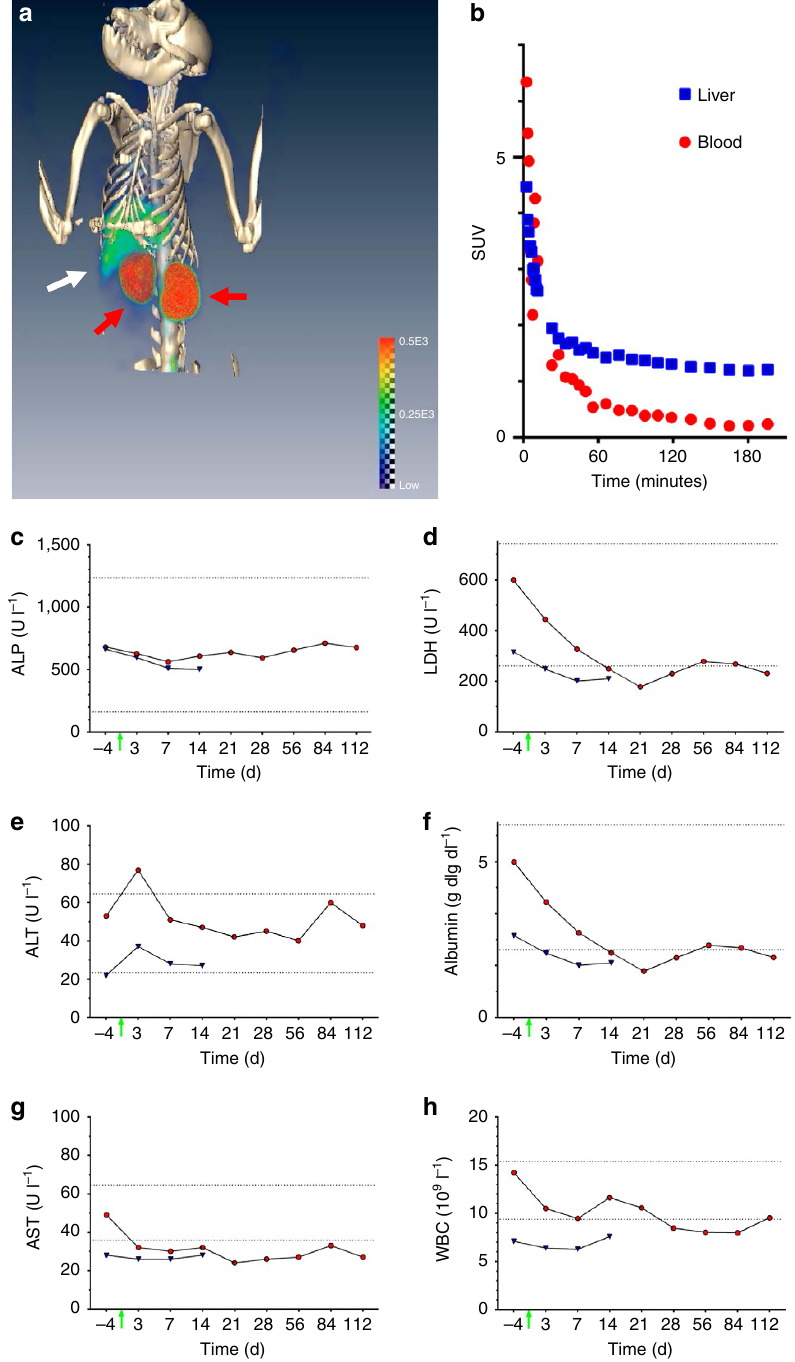
Figure 5 | Pharmacokinetics and toxicology of fCNT in non-human primates. A pair of 5kg cynomolgus monkeys received an intravenously administered dose of [ 86 Y]fCNT (1mgkg (cid:2) 1 ). ( a ) A fused PET/CT image of [ 86 Y]fCNT showing liver (white arrow) and kidney (red arrows) distribution. ( b ) Time– activity curves for blood (red circles) washout and hepatic (blue squares) uptake. Biomarkers for hepatic functions in the pair of animals (red circles and blue triangles) were unchanged relative to baseline values at day minus 4 (NB, the green arrow indicates the time of injection and imaging). The values for ( c ) alkaline phosphatase (ALP), ( d ) lactate dehydrogenase (LDH), ( e ) alanine aminotransferase (ALT), ( f ) albumin, ( g ) aspartate aminotransferase (AST), and ( h ) white blood cell (WBC) count agreed with published ranges (dotted lines) for similarly aged male animals 32